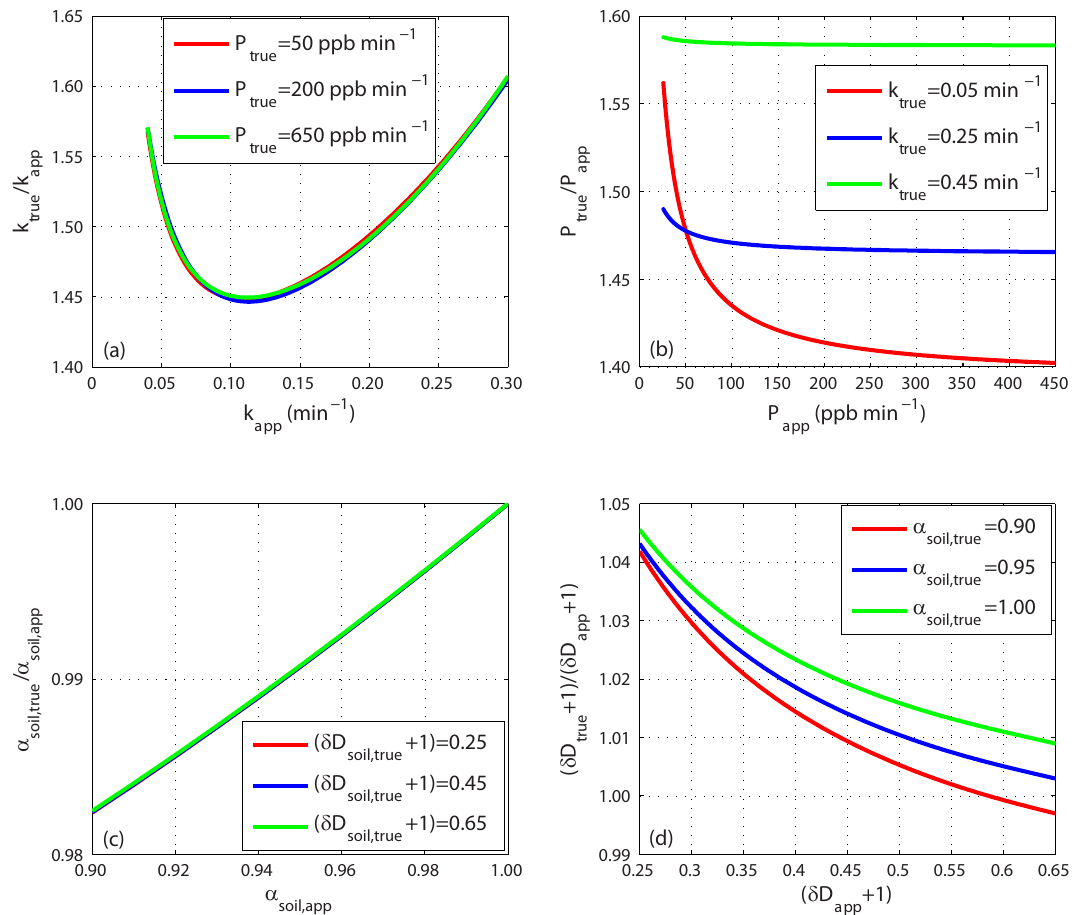
Figure 10. (a) The relationship between k true /k app and k app for P true of 50, 200 and 650ppbmin − 1 ; (b) between P true /P app and P app for k true of 0.05, 0.25 and 0.45min − 1 ; (c) between α soil , true /α soil , app and α soil , app for ( δ D soil , true + 1) of 0.25 to 0.65 for k true = 0.25min − 1 and P true = 50ppbmin − 1 ; (d) between ( δ D soil , true + 1) / ( δ D soil , app + 1) and ( δ D soil , app + 1) for α soil , true of 0.90 to 1.00 for k true = 0.25min − 1 and P true = 50ppbmin − 1 . The parameters of the sampling setup are V (cid:48) = 22.8L, f = 2Lmin − 1 , (cid:49)t = 10 min and the pressures inside the flasks and chamber are 200 and 100kPa,